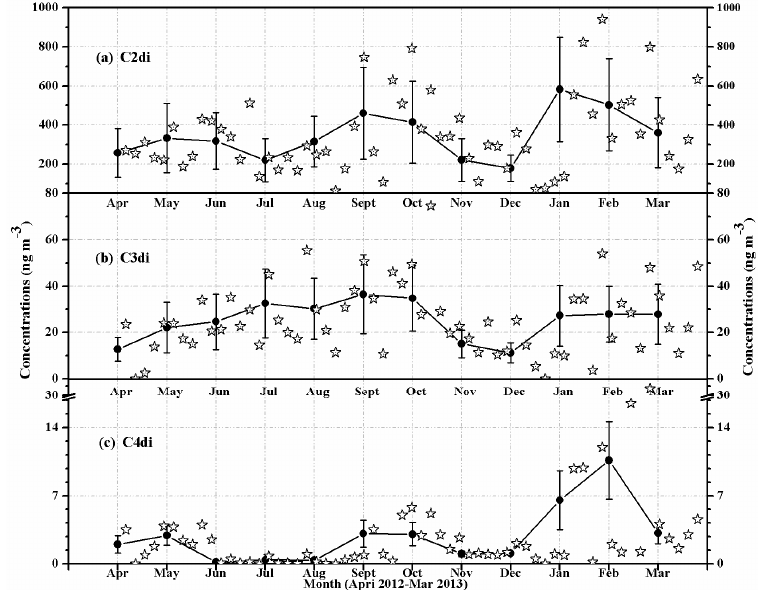
Figure 2. Seasonal variations in the mass concentrations of ( a ) oxalic (C 2 ), ( b ) malonic (C 3 ), and ( c ) succinic (C 4 ) in the PM 10 aerosols of Huangshi, Central China. The solid lines indicate monthly mean data points.